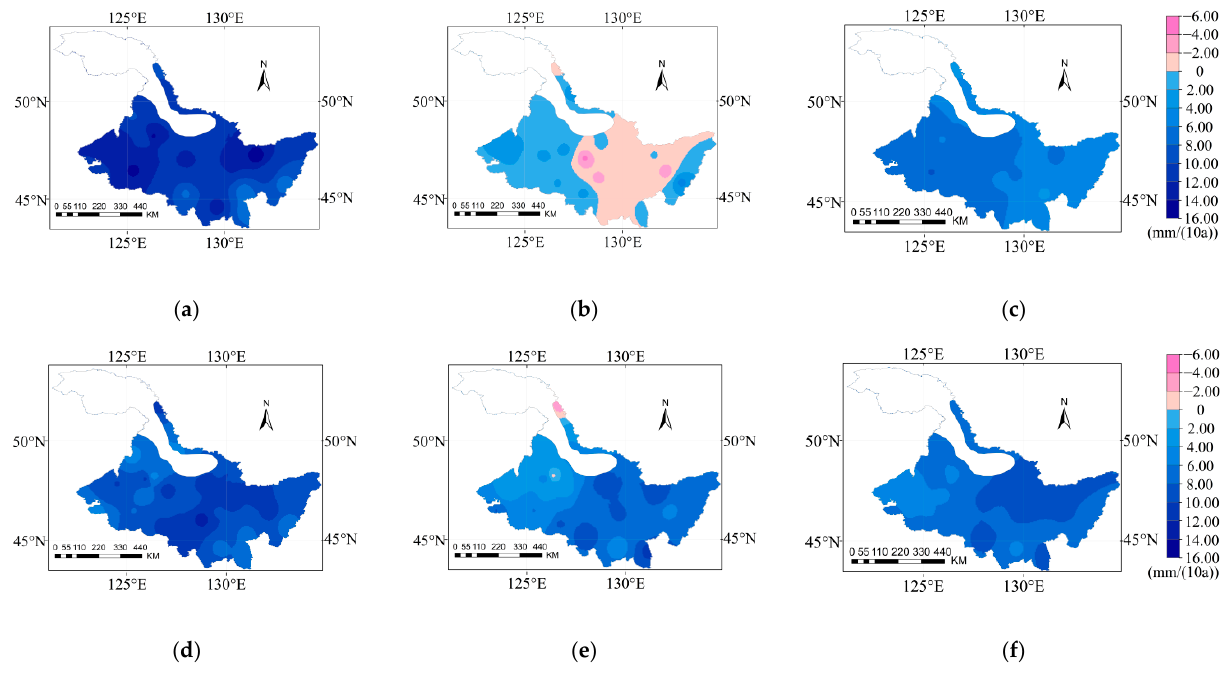
Figure 7. Climate tendency rates of ET c in the periods ( a ) 2021–2050, ( b ) 2051–2080, and ( c ) 2021–2080 under RCP4.5, and in the periods ( d ) 2021–2050, ( e ) 2051–2080, and ( f ) 2021–2080 under RCP8.5 during the soybean growth period.